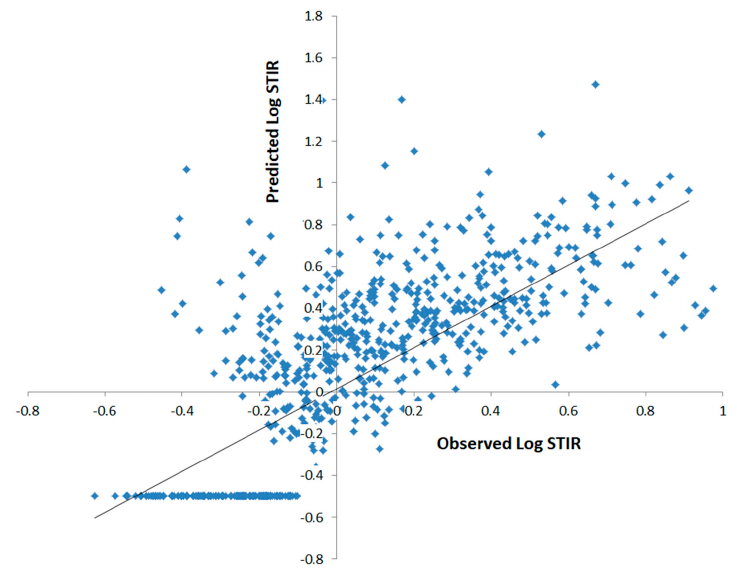
Figure 6. Scatter plot of observed and predicted log (STIR) (by single hidden layer MLP model) for test data in the continental US.